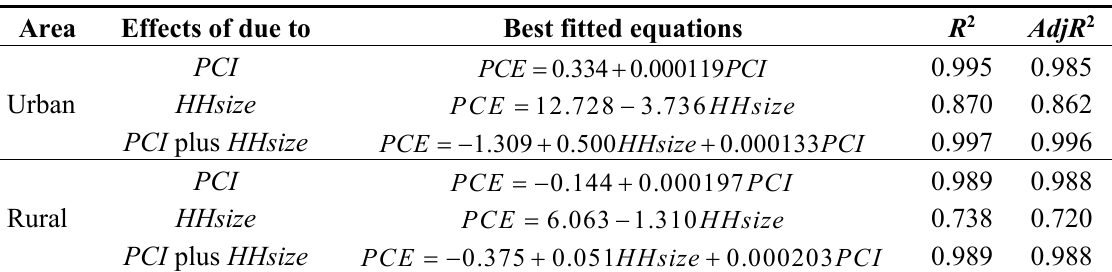
Table 5. Effect of household size ( HHsize ) and PCI on per person household carbon emission ( PCE ) in urban and rural